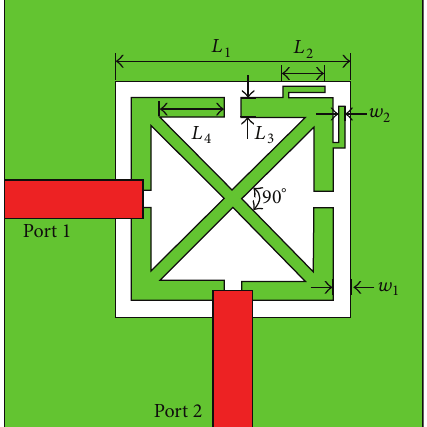
Figure 7: Top view of the proposed 𝑡 miniaturized dual-mode square